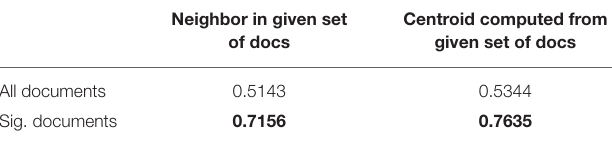
TABLE 1 | Nearest neighbor classification of Science News documents across all documents and across only significant documents. Neighbor in given set Centroid computed from of docs given set of docs All